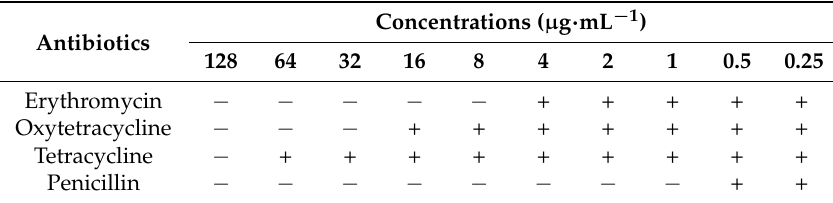
Table 1. Minimal inhibitory concentrations (MICs) of four antibiotics in strain E2S.